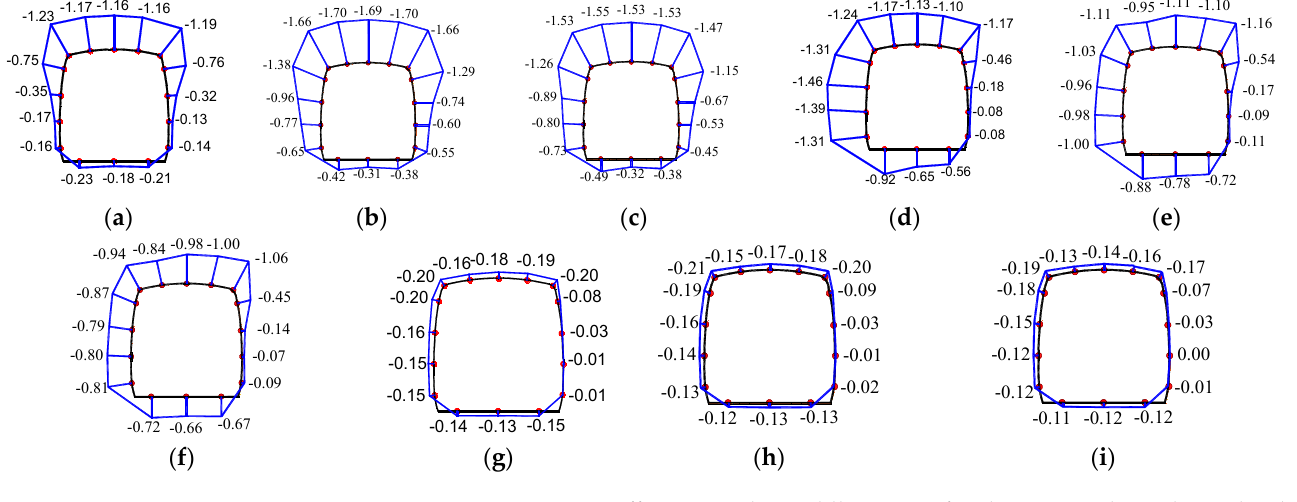
Figure 14. Mean pressure coefficients at the middle section for three ground roughness levels ( S = 0.35). ( a ) λ = 0, R / R c = 0; ( b ) λ = 5%, R / R c = 0; ( c ) λ = 25%, R / R c = 0; ( d ) λ = 0, R / R c = 1.5; ( e ) λ = 5%, R / R c = 1.5; ( f ) λ = 25%, R / R c = 1.5; ( g ) λ = 0, R / R c = 3.75; ( h ) λ = 5%, R / R c = 3.75; ( i ) λ = 25%, R / R c =